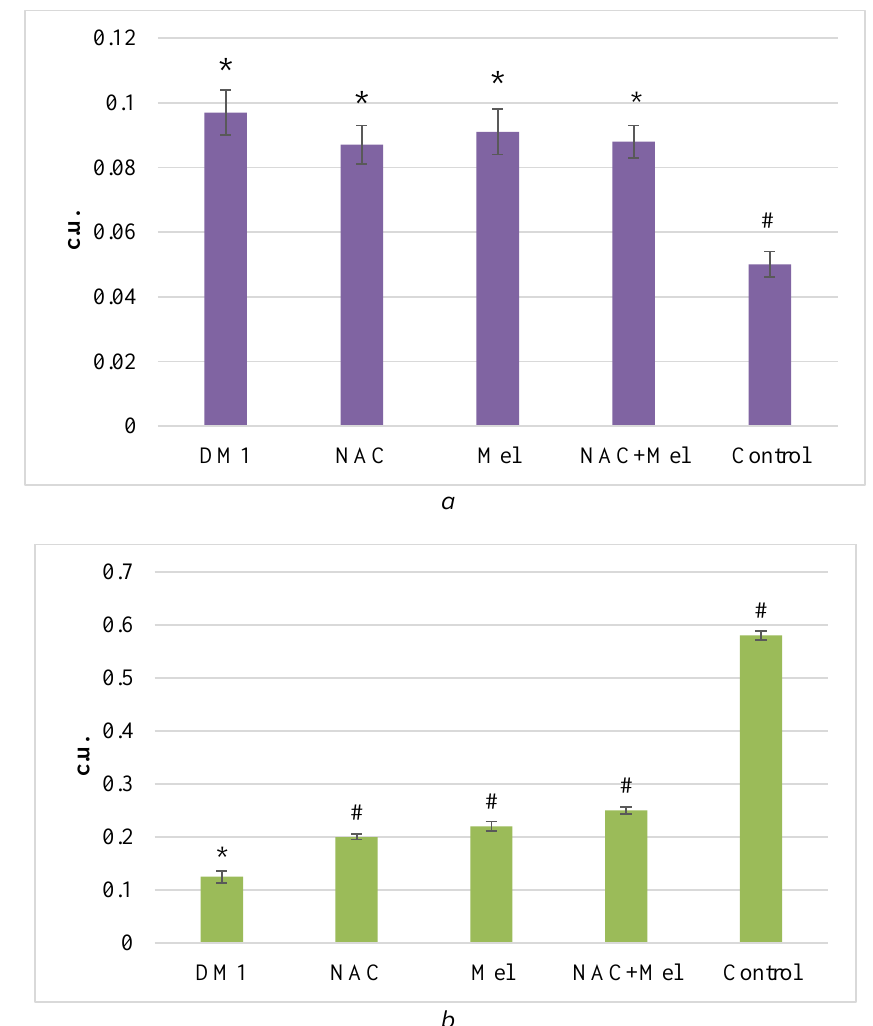
Fig. 3. Influence of N-acetylcysteine (NAC) and melatonin (Mel) on the level of complexes of NO-FeS-proteins and activity of complex I ETL of mitochondria of rat cell cultures: a – level of complexes of NO-FeS proteins; b – activity of complex I ETL mitochondria. DM 1 (rats with diabetes mellitus 1 receiving physiological saline per os); NAC (rats with DM 1, administered NAC at a dose of 1.5 g/kg per os); Mel (rats with DM 1 receiving Mel in a dose of 10 mg/kg per os); NAC+Mel (diabetic rats receiving NAC and Mel per os combination therapy); control (intact rats). NAC/Mel or NAC+Mel were administered within 5 weeks; * in comparison with control, p<0,05; # in comparison with DM 1,